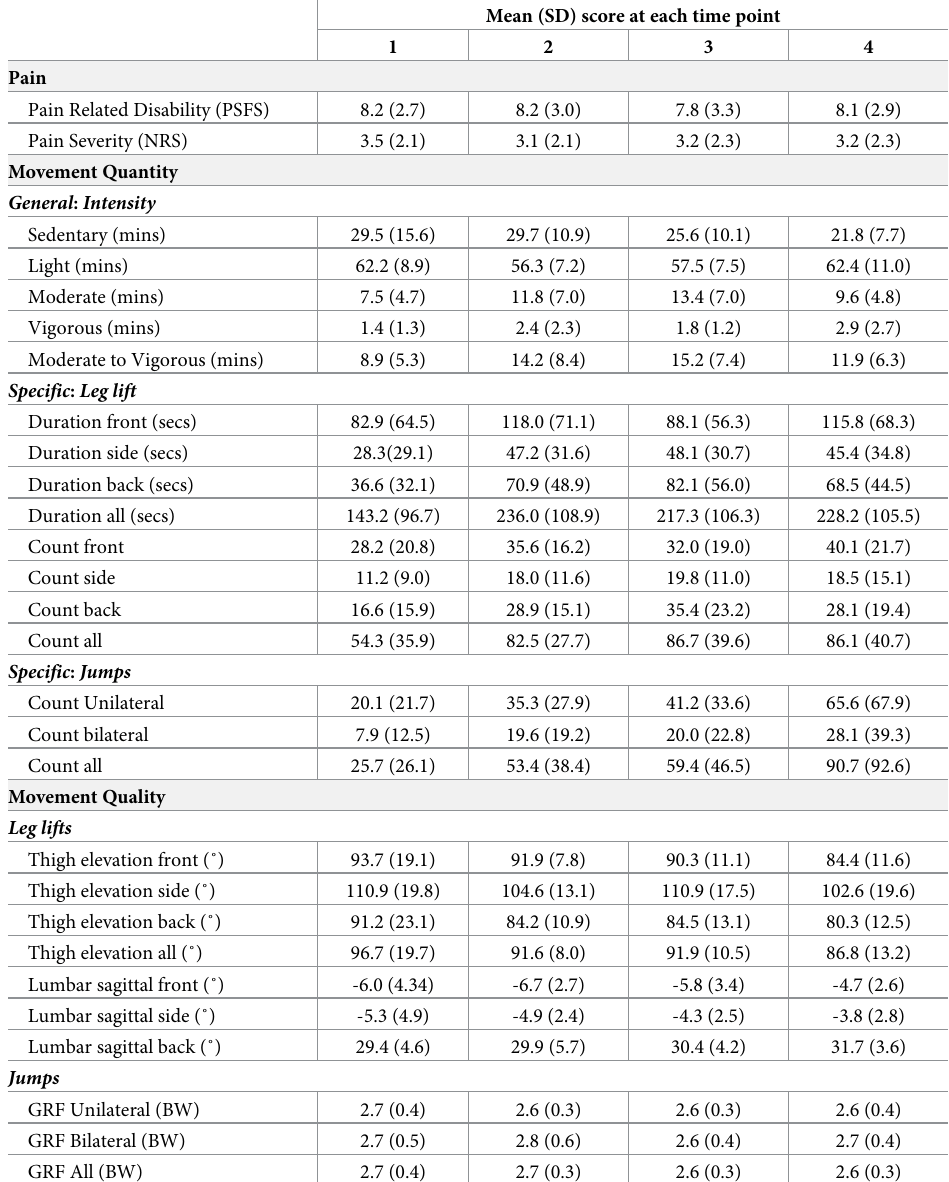
Table 2. Overall mean values for each variable at each time